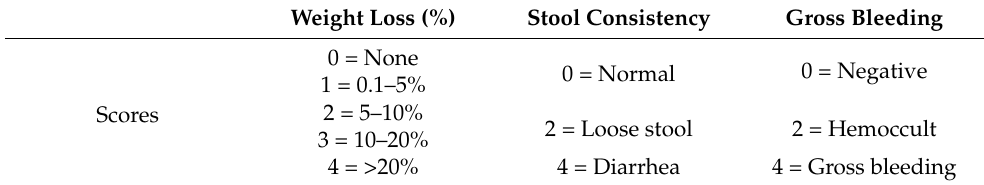
Table 1. Assessment by disease activity index